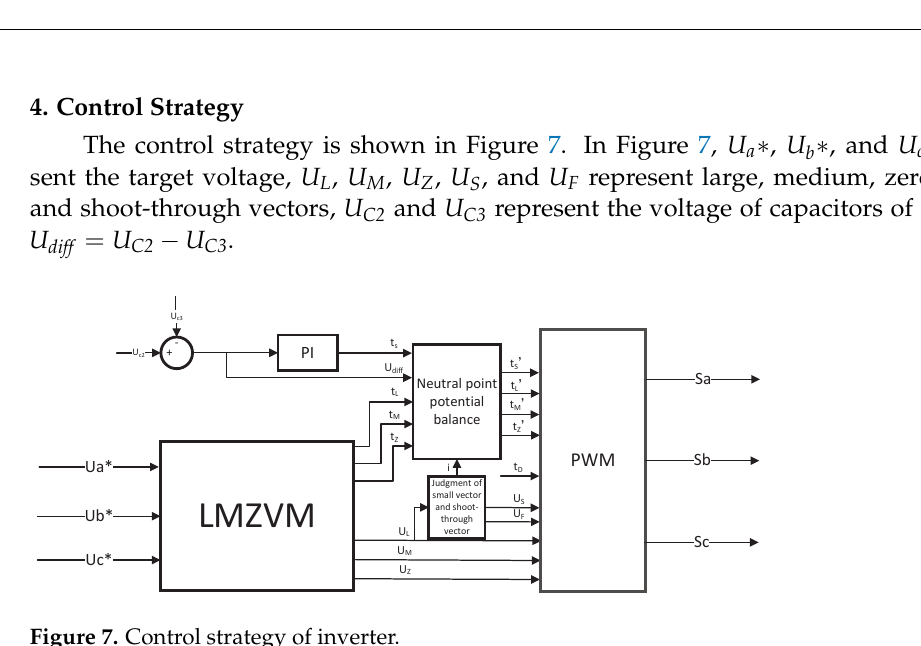
Figure 7. Control strategy of inverter.